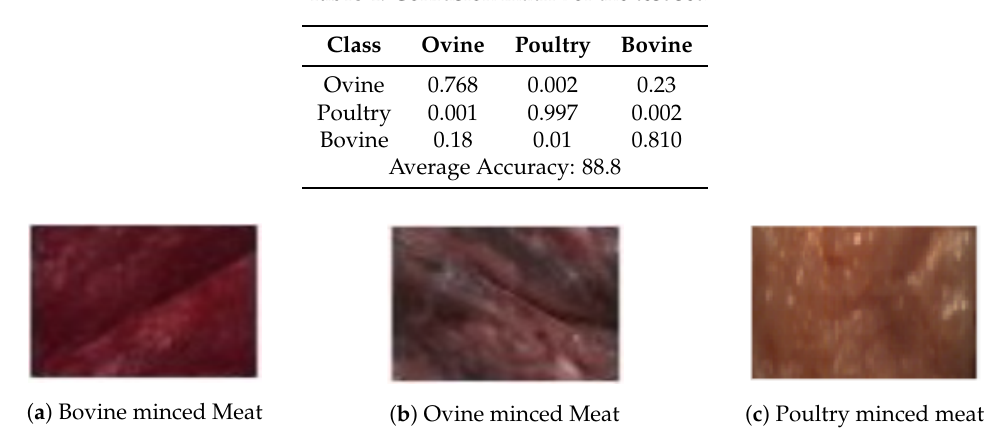
Table 4. Confusion matrix of the test set.